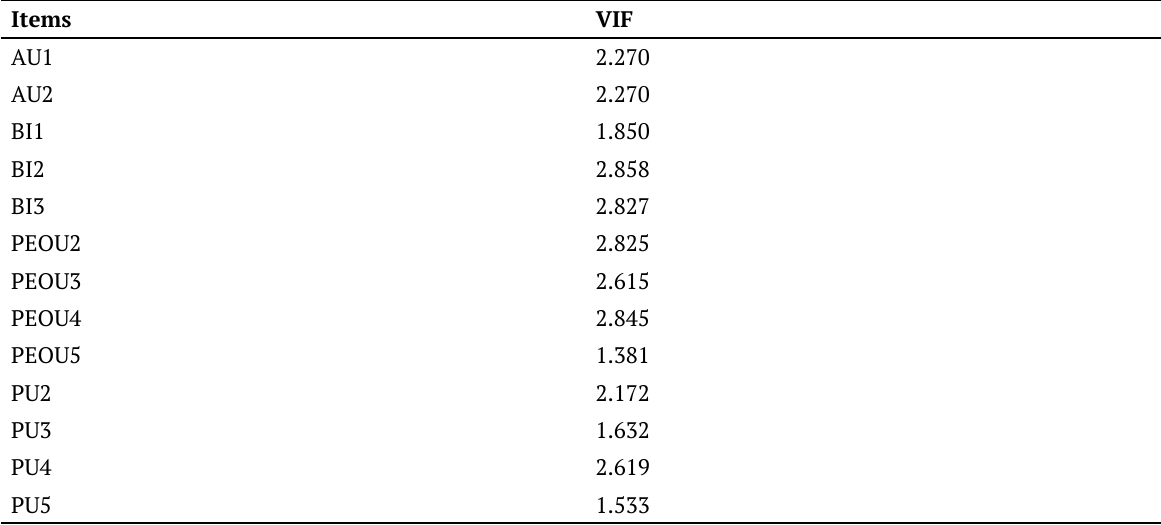
Table 6. Collinearity Statistics (VIF) – Outer